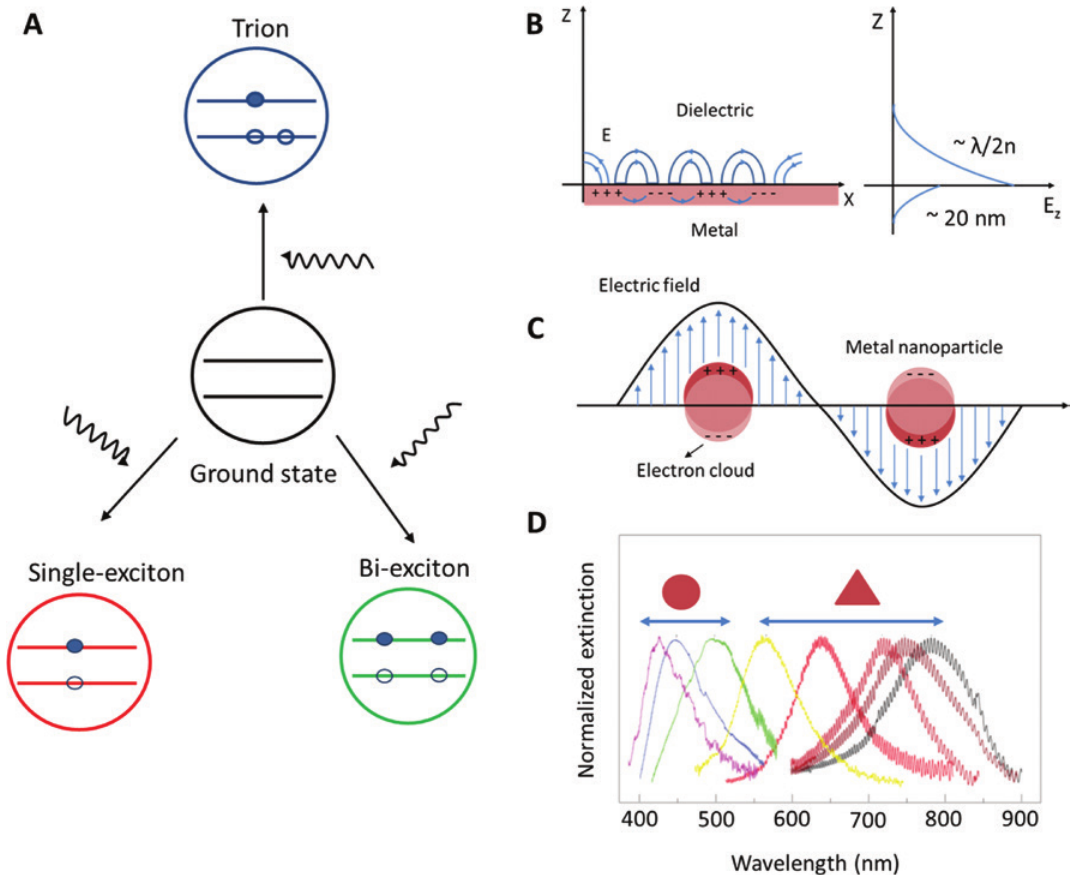
Figure 1: Excitations in QDs and plasmonic systems. (A) Schematic representation of single-exciton and multi-exciton generation in QD. (B) Pictorial illustration of electromagnetic wave and surface charges at the metal-dielectric interface along with electric field decay with distance in a direction normal to the interface. (C) Schematic diagram of LSP on a metal nanoparticle. (D) Increasing the size of silver nanodisks and nanoprisms tunes their LSP spectra. As the size is increased, the plasmon peak shifts to higher wavelengths. (D) is reprinted with permission from Ref.